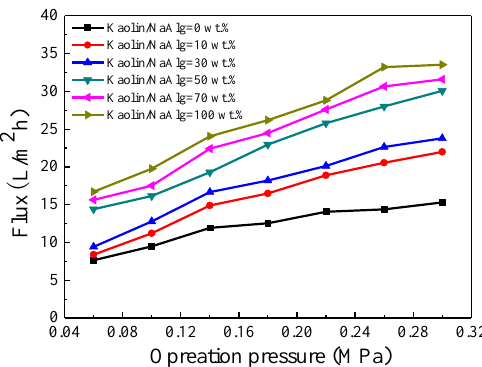
Figure 4. Pure water flux (PWF) of kaolin/CaAlg membranes prepared with different kaolin contents under different pressures.